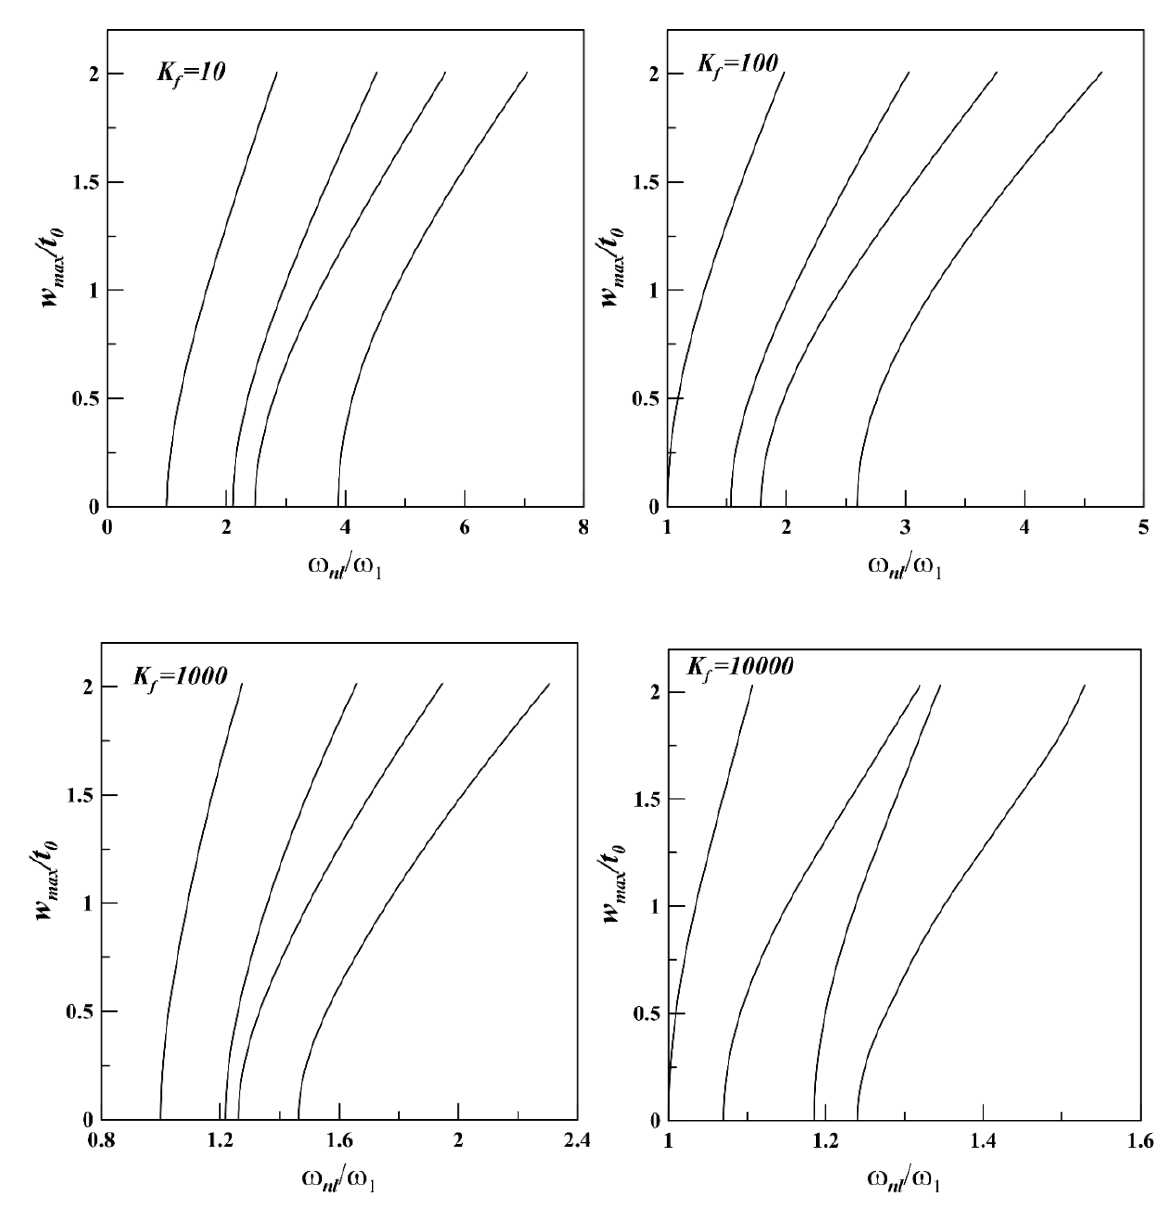
Figure 7: Backbone curves of CCSF plate for various foundation stiffnessat α , β =